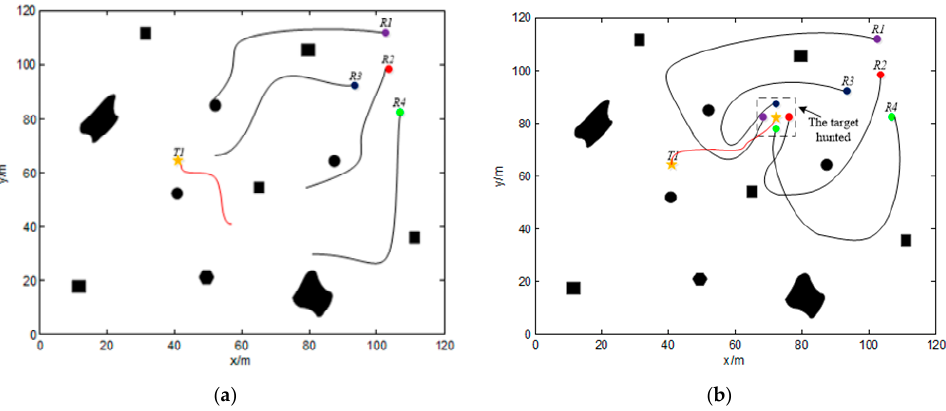
Figure 7. Hunting path with two different algorithms. ( a ) PSO algorithm; ( b ) IPF algorithm.